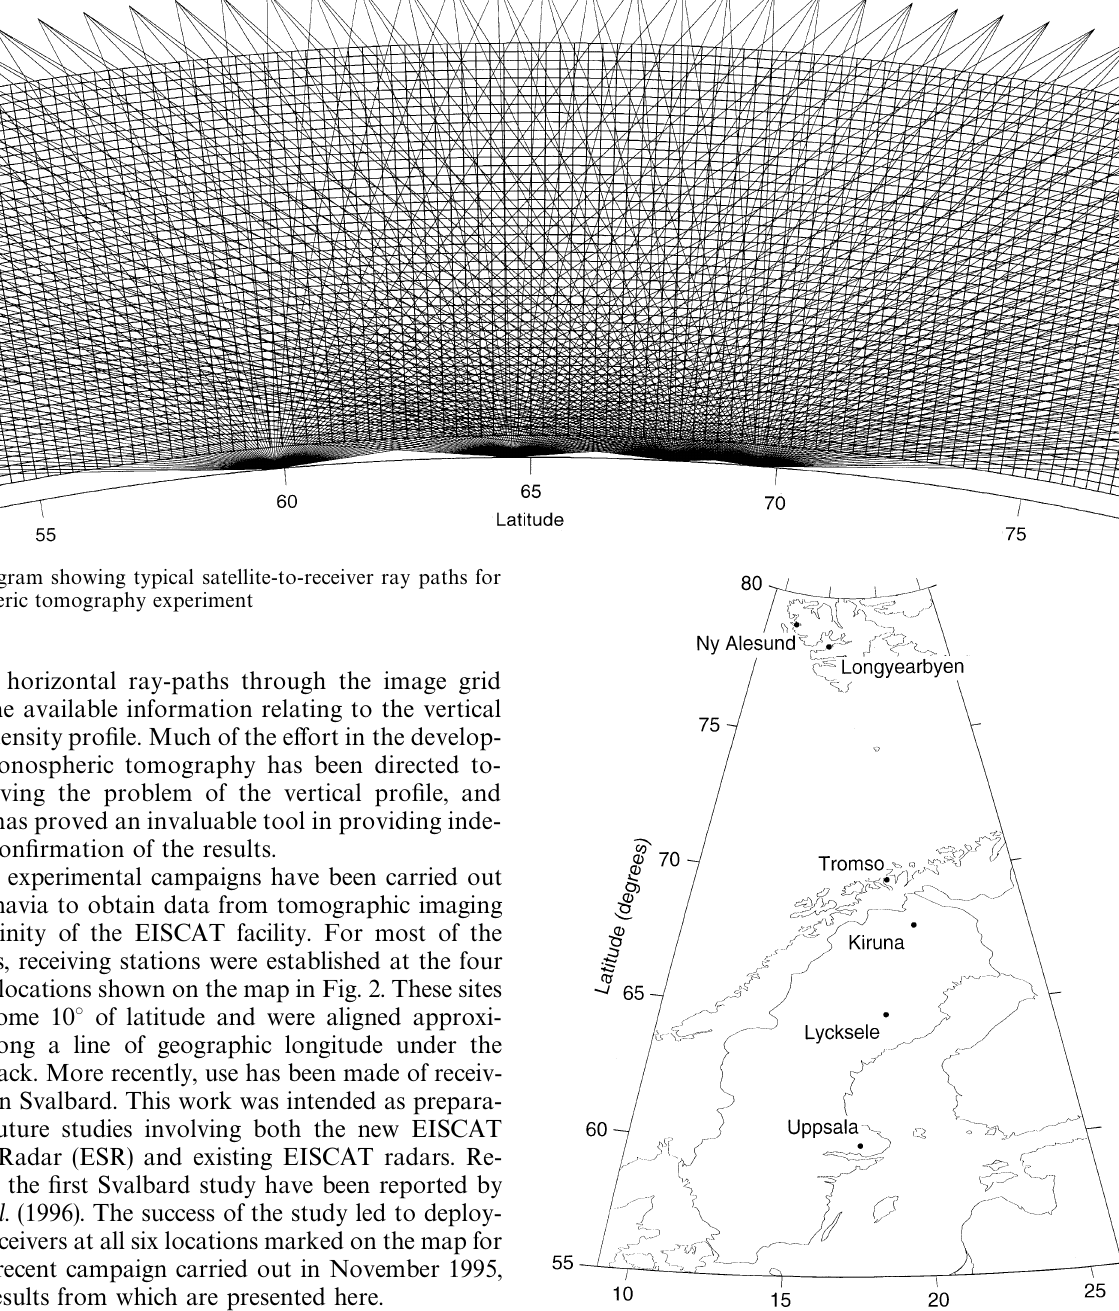
program uses the UHF radar in a meridional scan, ini- tially with the beam pointing nearly vertical at Troms (cid:249) , with subsequent southward motion in 56 steps of 0.125 ° ( & 15 km) at 300-km altitude. The complete scan covers some 7 ° latitude at this height, with height resolution being retained at about 30 $ 8 km through use of three radar controller programs. The cycle time for